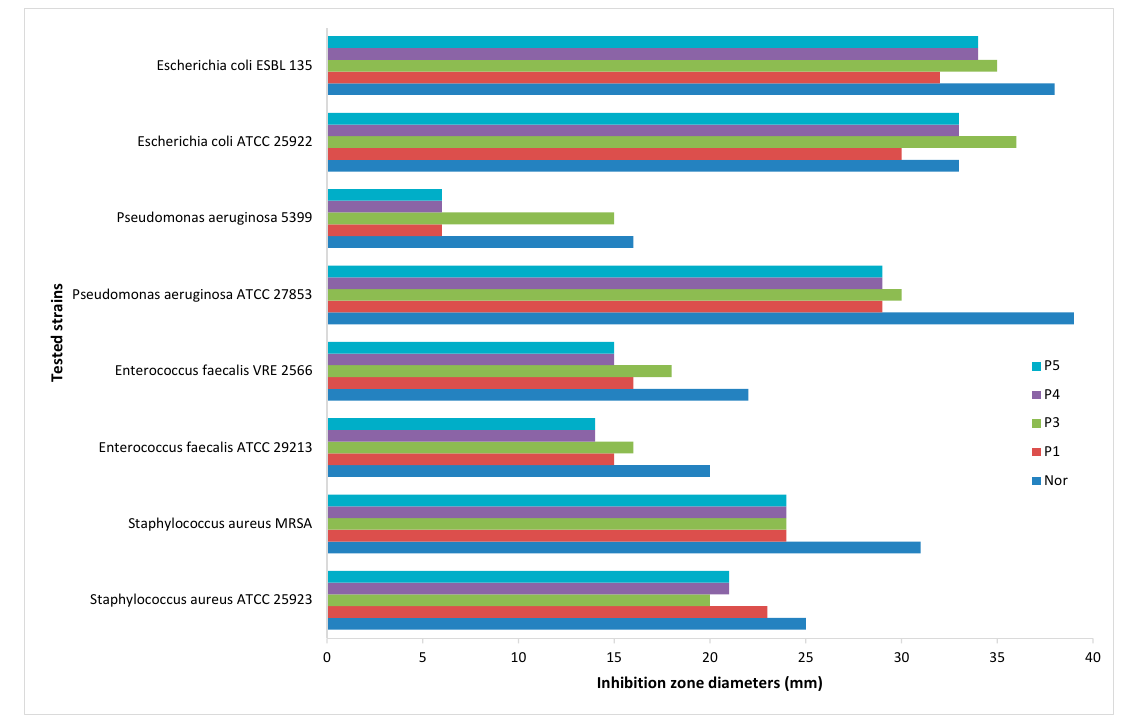
Figure 9. Graphic representation of inhibition zone diameters (mm).